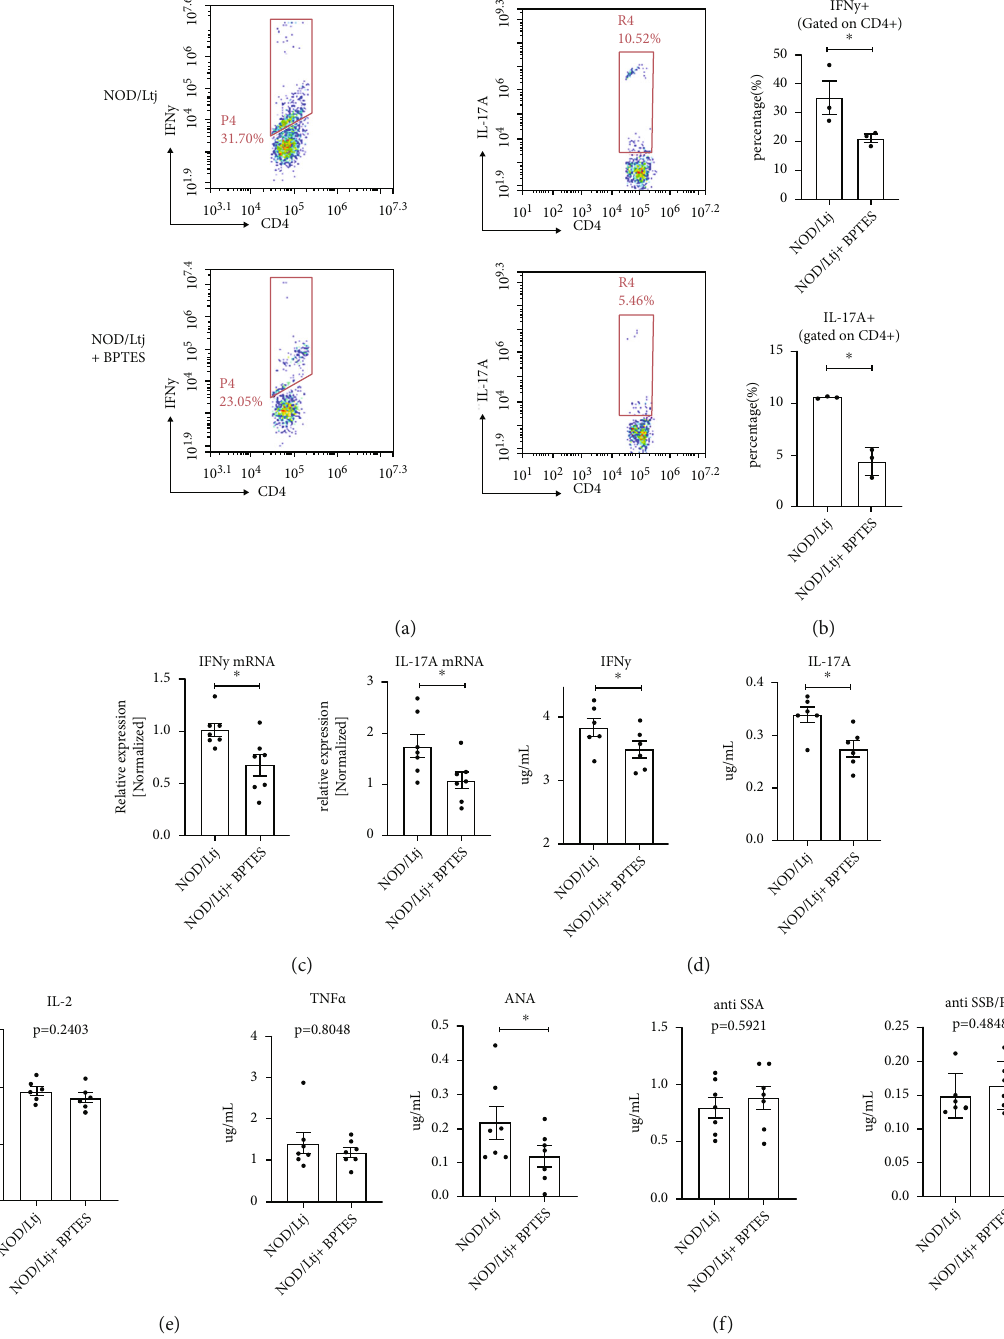
Figure 5: BPTES treatment selectively inhibited the e ff ector function of CD4+ T cells and the immune response in NOD/Ltj mice. (a, b) Representative pictures and statistical analysis of fl ow cytometry data of IFN γ -producing and IL-17A-producing cells in the CD4+ T cell population. (c) qRT – PCR analysis of IFN γ and IL-17A gene expression in NOD/Ltj mice treated with/without 10mg/kg BPTES. (d) ELISA quanti fi cation of IFN γ and IL-17A levels in circulating sera of the indicated NOD/Ltj mice. (e) ELISA quanti fi cation of IL-2 and TNF- α levels in circulating sera of the indicated NOD/Ltj mice. (f) ELISA quanti fi cation of ANA, anti-SSA, and anti-SSB levels in circulating sera of the indicated NOD/Ltj mice. Summary data are presented as ∗ p < 0 : 05 with unpaired two-tailed Student ’ s t